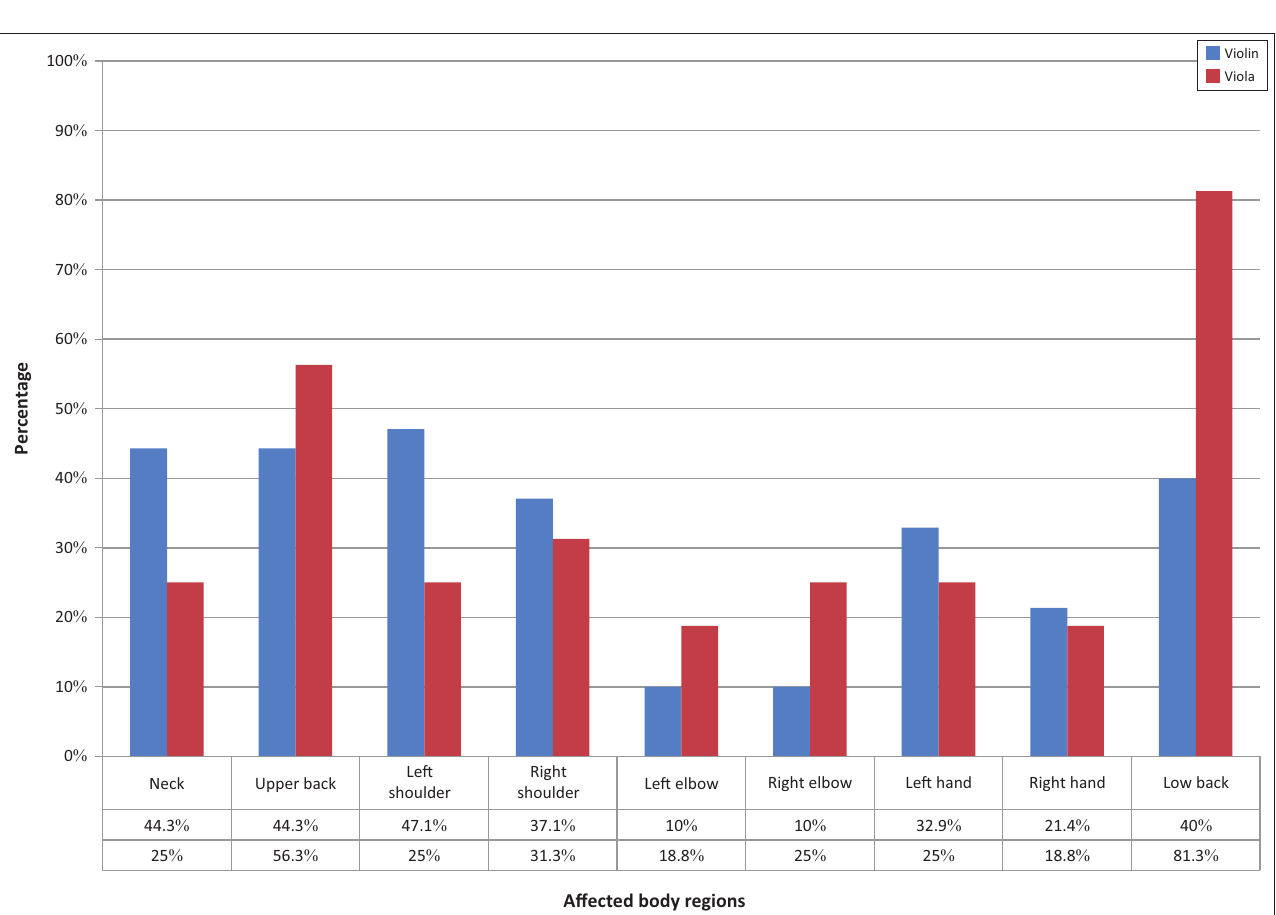
Neck Upper back